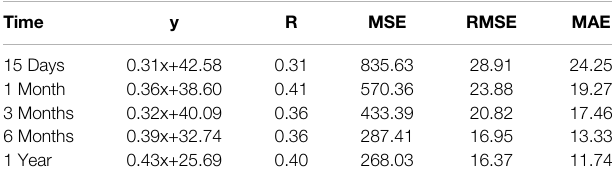
TABLE 1 | PM 10 2020 model performance statistics with different time period in Jiangsu